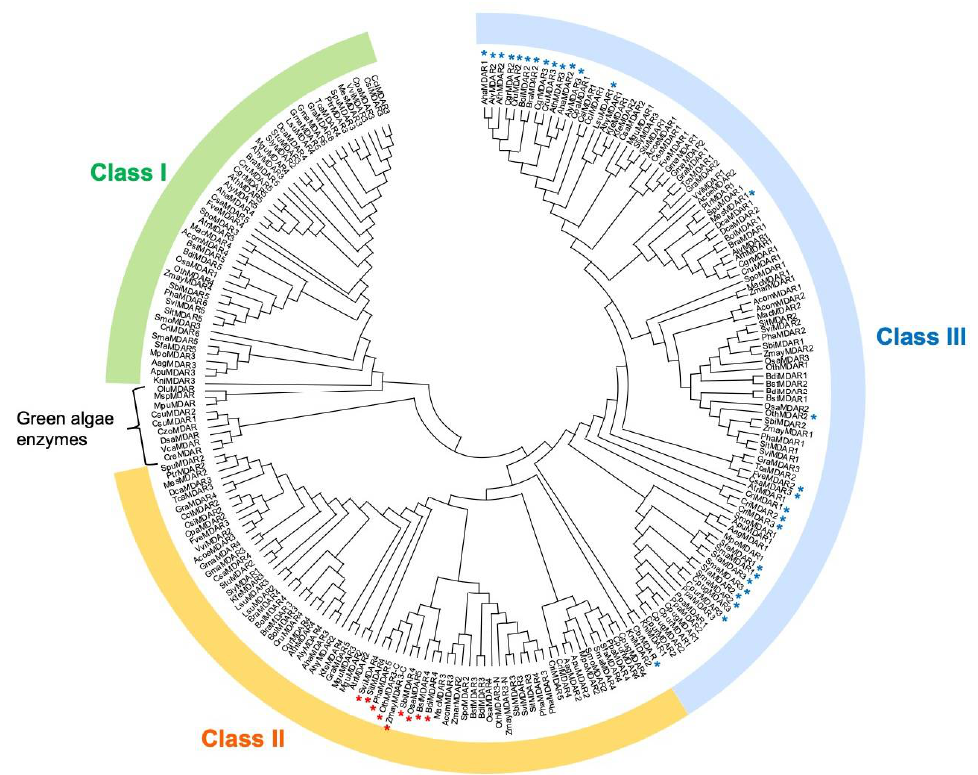
Figure 2. Phylogenetic tree of the MDAR sequences of algae and land plants. The phylogenetic tree was constructed using 220 MDAR sequences from 61 species (10 algae and 51 land plants). Class I enzymes are chloroplastic/mitochondrial isoforms, while class II enzymes are peroxisomal membrane-bound isoforms. Class III MDARs are cytosol/peroxisomal enzymes. Blue asterisks indicate class III enzymes without a peroxisome-targeting signal 1 (PTS1)-like sequence whose subcellular localization is restricted to the cytosol. Red asterisks indicate class II enzymes that lack the adjacent cluster of basic amino acids (e.g., ‘RRRRRW’ of AthMDAR4), and their subcellular localization remains